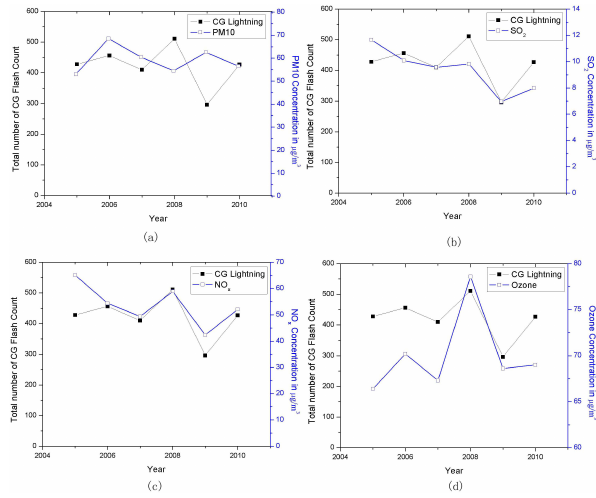
Figure 4. The mean annual variation of the number of CG light- ning flashes with annual average particulate matter (PM 10 ), sulfur dioxide (SO 2 ) , nitrogen oxides (NO x ) , surface ozone (O 3 ) concen- trations during premonsoon months for the whole studied period (2005 to